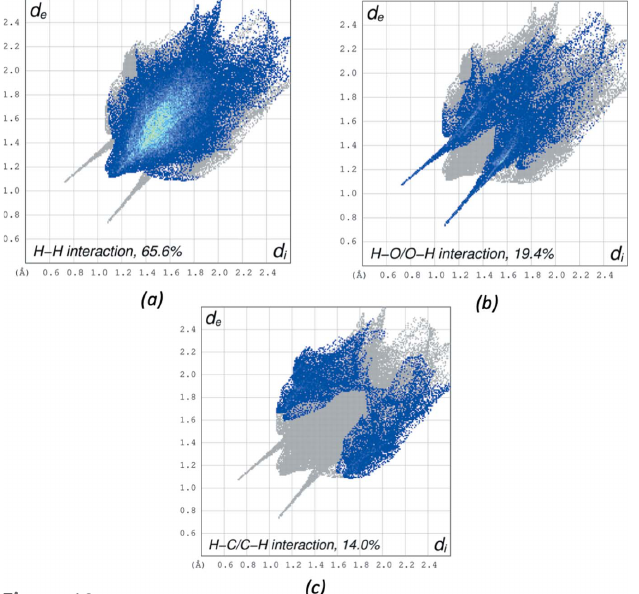
Figure 10 The two-dimensional fingerprint plots for II delineated into ( a ) H (cid:5)(cid:5)(cid:5) H contacts, ( b ) H (cid:5)(cid:5)(cid:5) O/O (cid:5)(cid:5)(cid:5) H contacts, ( c ) H (cid:5)(cid:5)(cid:5) C/C (cid:5)(cid:5)(cid:5) H contacts. Other contact contributions of less than 1% are omitted.